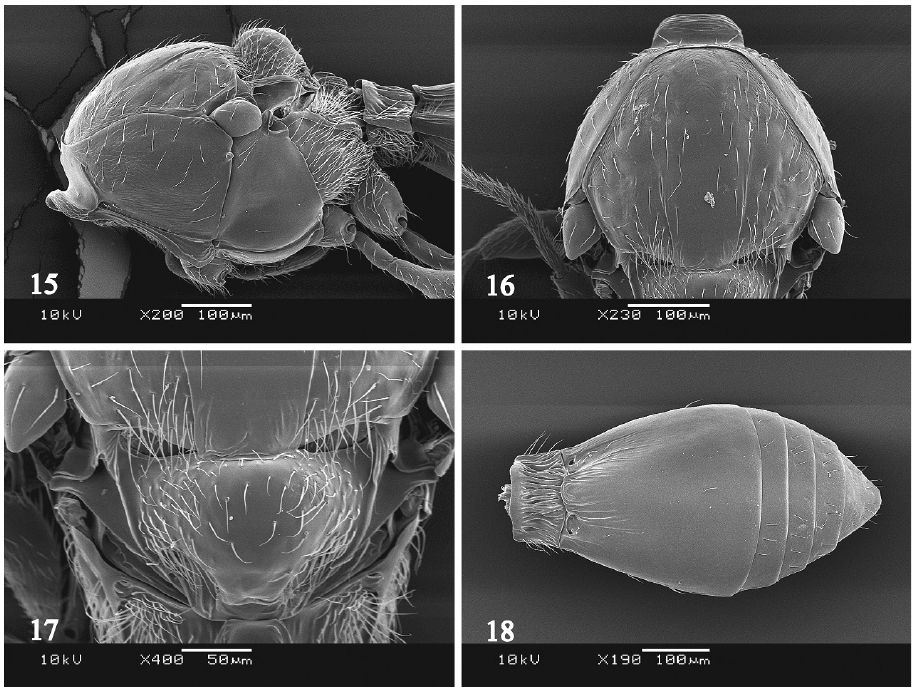
Figure 15–18. Platygaster urniphila . 15 female mesosoma, lateral view 16 female mesoscutum, dorsal view 17 female mesoscutellum, dorsal view 18 female metasoma, dorsal